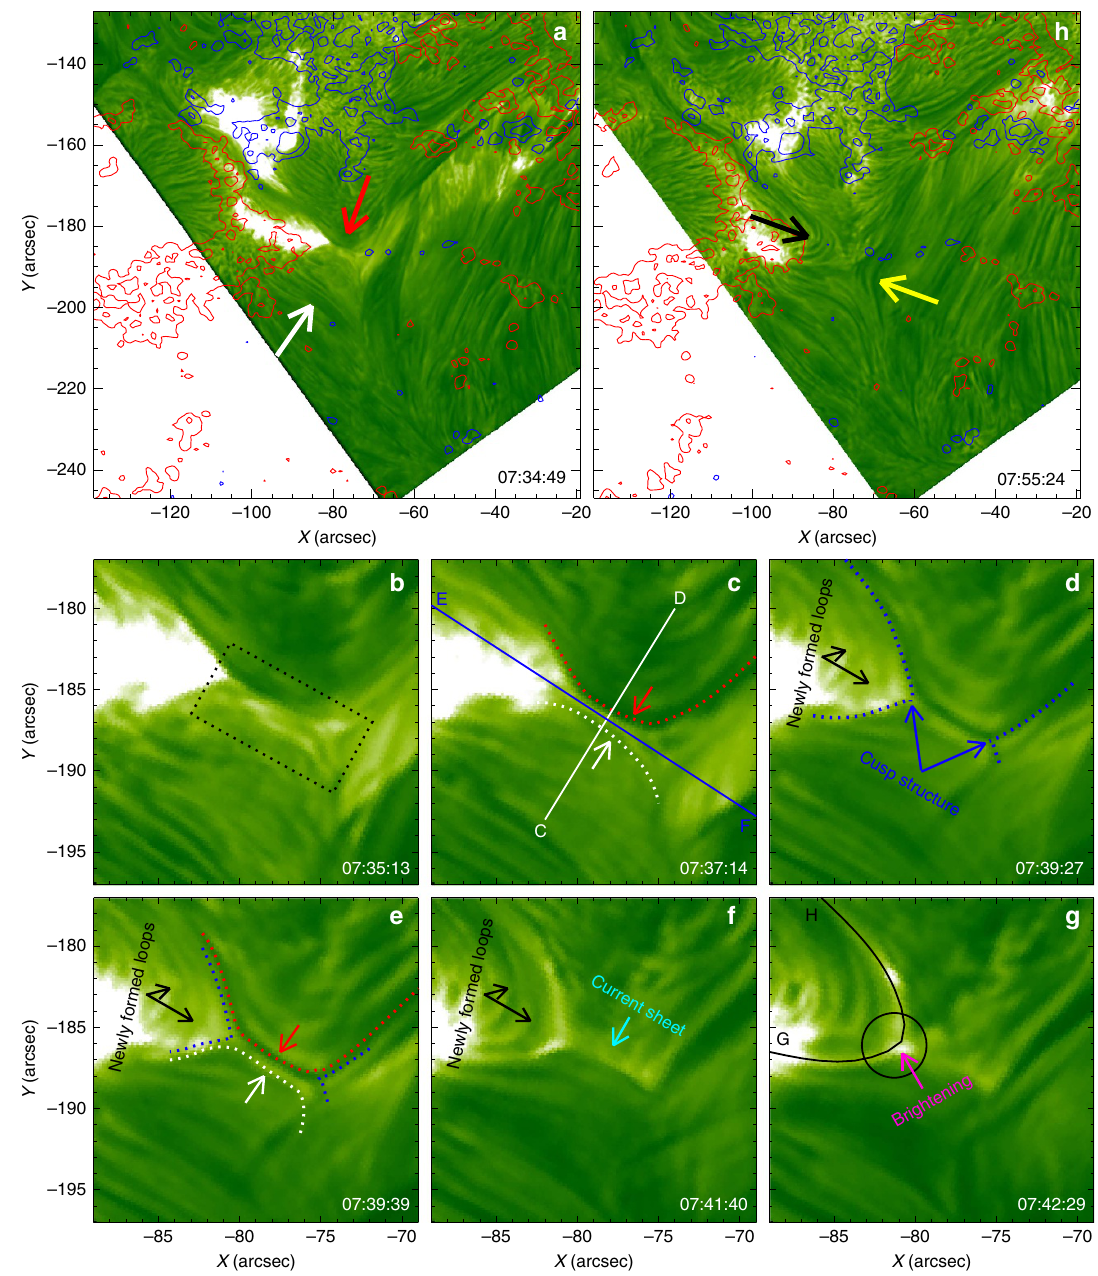
Figure 2 | Evolution of reconnection. ( a , h ) NVST H-alpha images in the early and late phases of the reconnection event, overlaid by red (blue) contours representing positive (negative) photospheric polarity from near-simultaneous HMI data. ( b – g ) NVST H-alpha images of the reconnection process in which the red- and white-dotted lines indicate the magnetic loops before the reconnection (with red arrows marking the filament threads and white arrows marking the chromospheric fibrils), the blue-dotted lines mark the cusp-shaped structures, and the black (yellow), cyan and pink arrows point to newly formed loops, current sheet and brightening, respectively. The three time-slice plots shown in Fig. 4 are made along the white solid line C–D, the blue solid line E–F and the black solid line G–H,